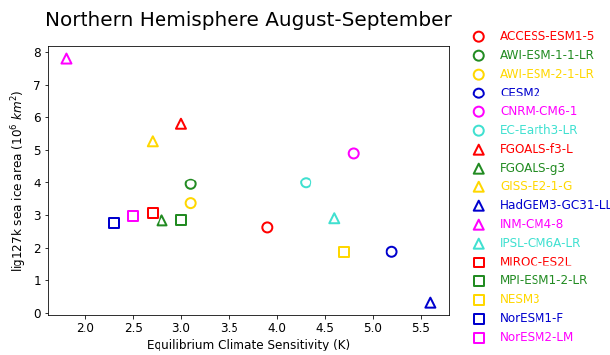
Figure 18. lig127k August–September NH sea ice area (10 6 km 2 ) versus equilibrium climate sensitivity (ECS,